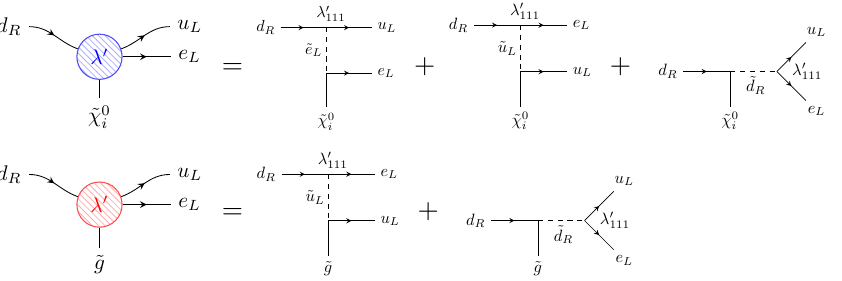
Figure 2 . Top: diagrams contributing towards the effective interactions at the vertices of the neutralino exchange diagrams in figure 1. Bottom: similar diagrams contributing towards the gluino exchange effective